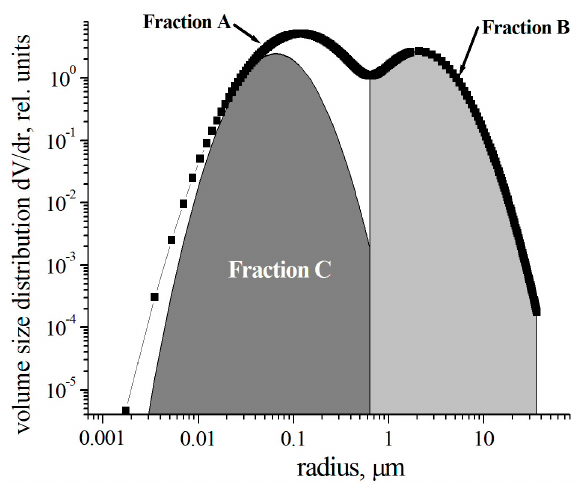
Figure 2. Schematic presentation of absorbing matter distribution within the total distribution of aerosol particles.